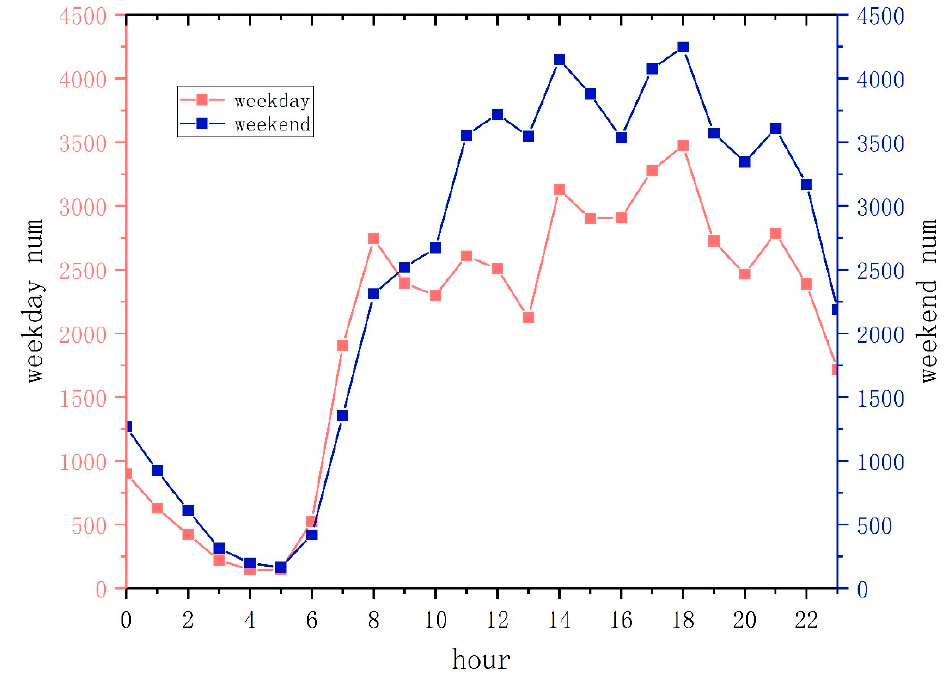
Figure 2. Resident commuting time–volume chart for weekdays/weekends.